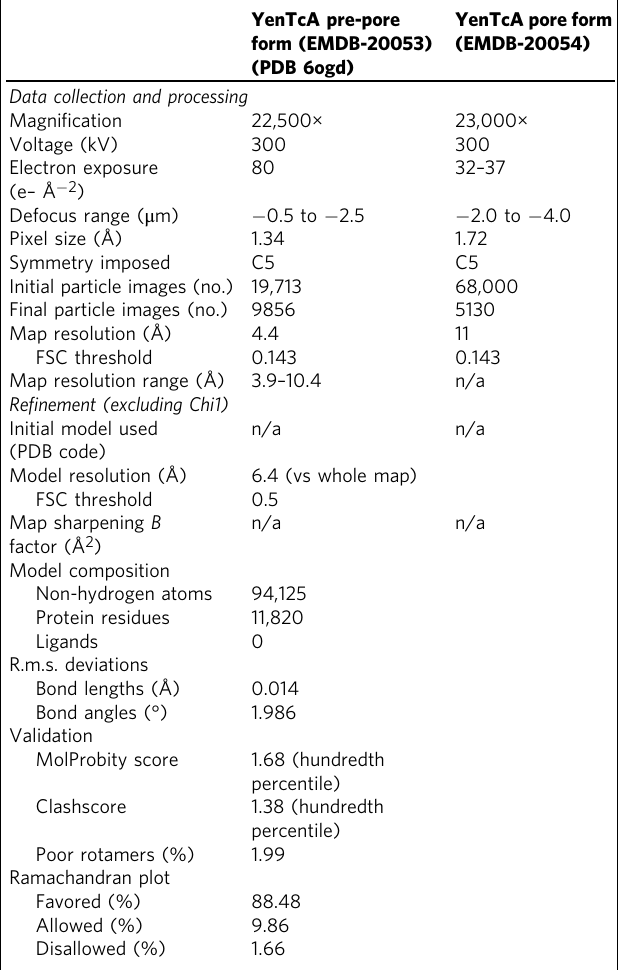
Table 1 Structure determination and model